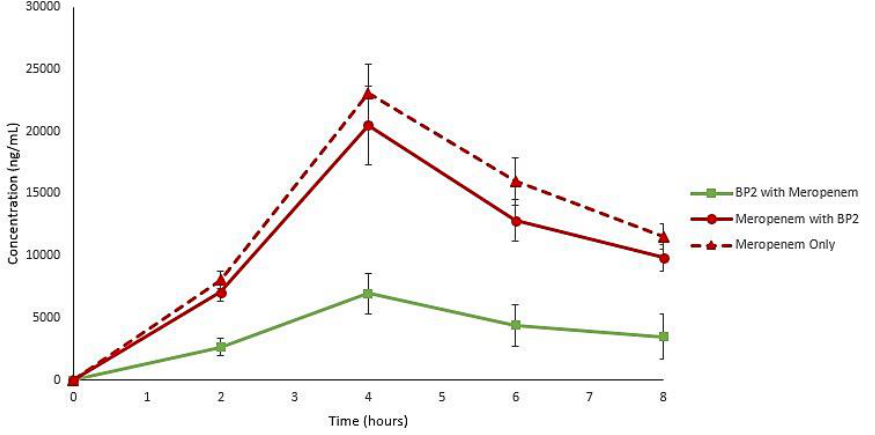
Figure 6. Plasma BP2 and meropenem concentrations over the eight-hour treatment period. BALB/c mice were infected intramuscularly (IM) in the right thigh with 10 6 –10 8 K. pneumoniae NDM cfu/mL. Treatment was initiated two hours post infection with either S, M, or BP2. Four treatment doses were administered via intraperitoneal (IP) injection every two hours. Data are presented as a mean ± SD ( n = 6). Meropenem-only (red triangle)—animals treated with meropenem only, Meropenem with BP2 (red circles)—meropenem concentration when animals were treated with the BP2 combination. BP2 with meropenem (green square)—concentration of BP2 when animals were treated with the meropenem combination.